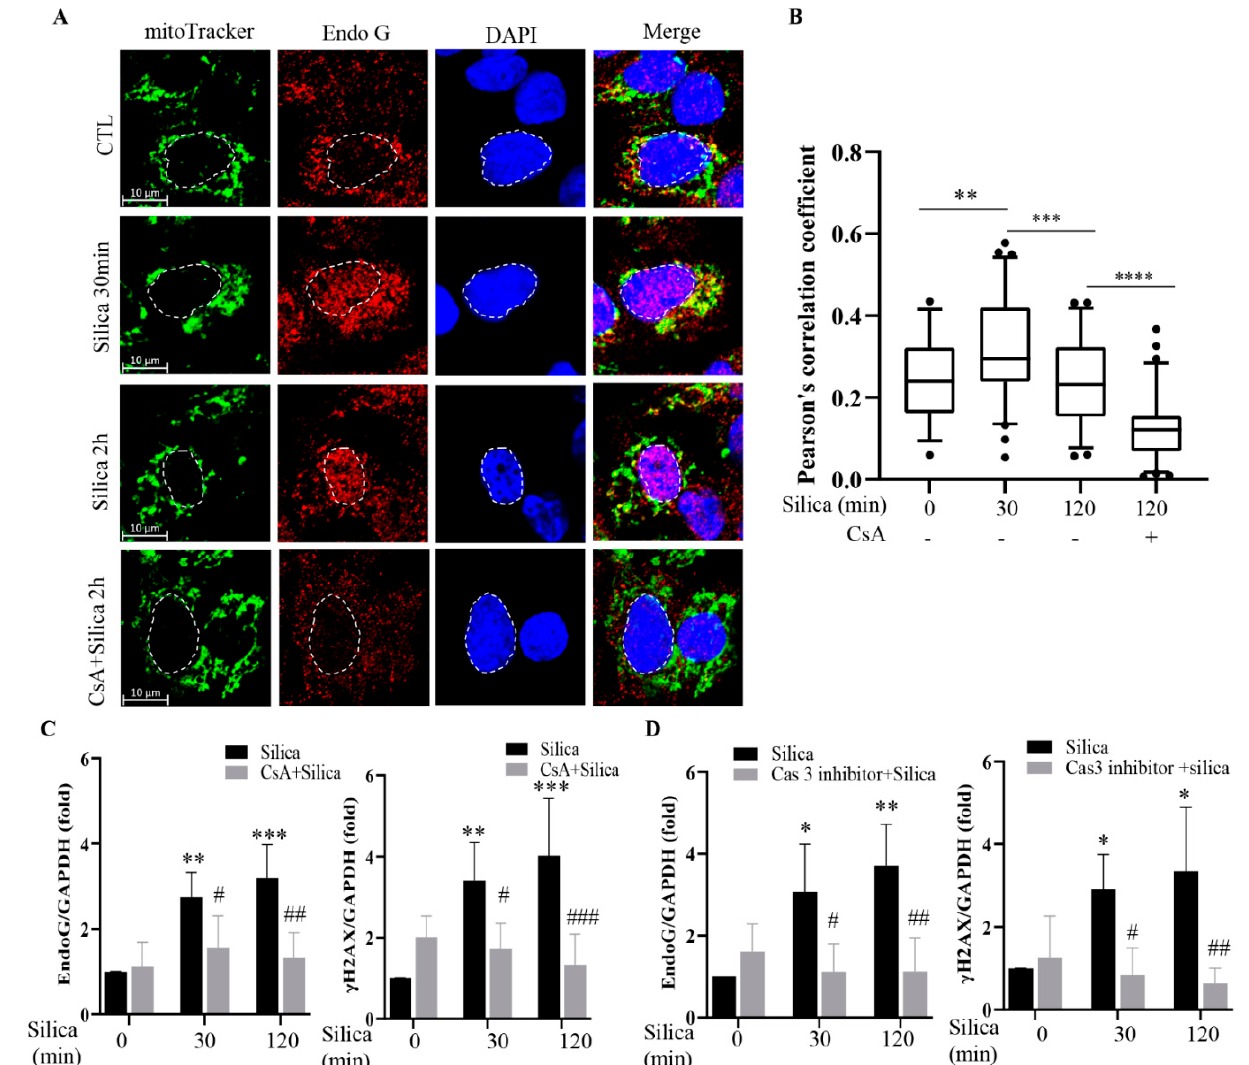
Figure 5. Cyclosporin A (CsA) prevents silica-induced depletion of mitochondrial EndoG, EndoG translocation and DNA damage. In ( A ), representative confocal images showing EndoG (red), mi- toTracker (green), and nuclear (blue) staining in 16HBE cells exposed to silica (5 µ g/cm 2 ) for times indicated. Cells pretreated with CsA (20 µ M) for 1 h are shown in the bottom row. In ( B ), EndoG and mitoTracker colocalization is quantified. In ( C ) 16HBE cells were pretreated with CsA (20 μ M) for 1 h and then exposed to silica (5 μ g/cm 2 ) for times indicated. Cell lysates were analyzed for EndoG and γ H2AX by Western blotting. In ( D ) 16HBE cells pretreated with Caspase-3 inhibitor (10 μ M) for 1 h and followed by silica (5 μ g/cm 2 ) for times indicated. Cell lysates were analyzed for EndoG and γ H2AX by Western blotting. Bars in B show median with 95% confidence interval. Bars in C and D show means ± SD. All experiments were performed at least in triplicate. * p < 0.05, ** p < 0.01, *** p < 0.001, **** p < 0.001 compared to control. # p < 0.05, ## p < 0.01, ### p < 0.001 compared to silica exposure, as determined by ANOVA. The mitochondrial depolarization plays a critical role in sub-lethal apoptosis signal- ing [6–8]. In our previous studies [3,4], we stabilized mitochondria with cyclosporin A (CsA) to prevent DNA damage. The CsA blocks the mitochondrial permeability transition pore (MPTP) and prevents depolarization [22]. Here, we used CsA to investigate the role of depolarization in EndoG translocation. As shown in Figure 5A,B, CsA pretreatment for 120 min prevented the effect of CSi on EndoG translocation as well as the merged, yellow